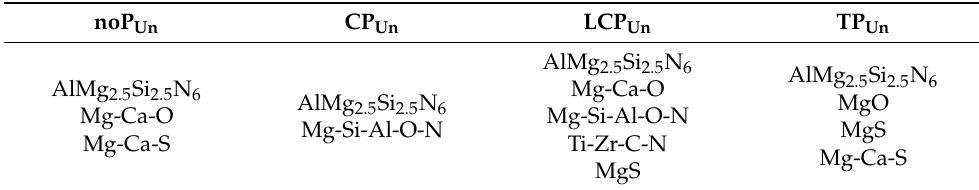
Table 6. Summary of the compounds found and identified in the graphite nodules in each